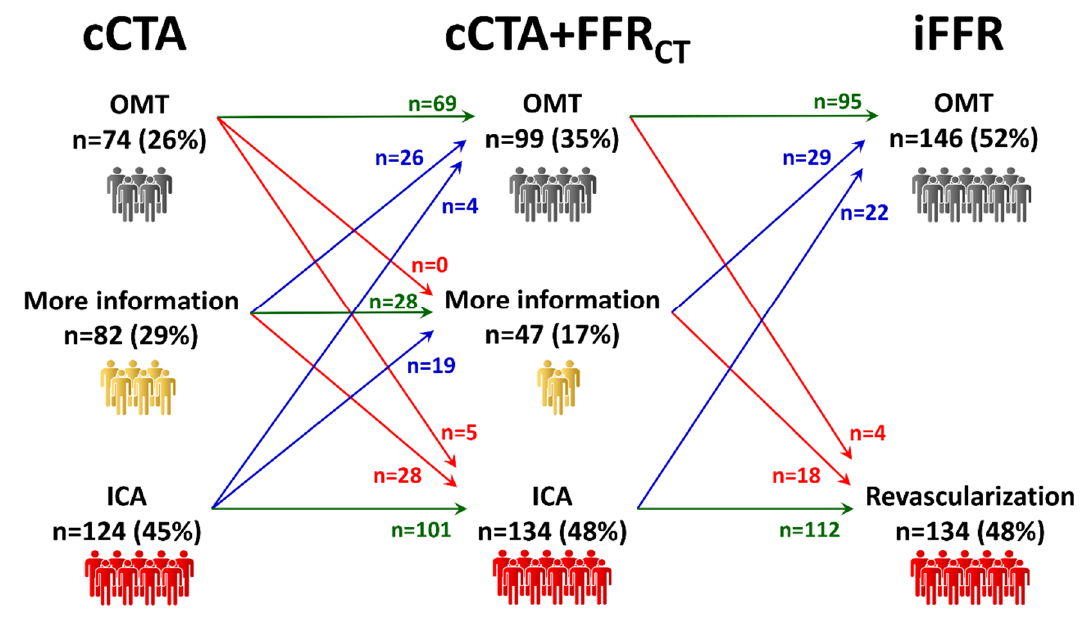
Figure 3. Management according to the addition of FFR CT to cCTA. If FFR CT is added to cCTA, there is a substantial equal redistribution of patients previously without a clear management indication to OMT or to revascularization. cCTA: coronary computed tomography angiography; OMT: optimal medical treatment; ICA: invasive coronary angiography; FFR CT : computed tomography-derived fractional flow reserve; iFFR: invasive fractional flow reserve.